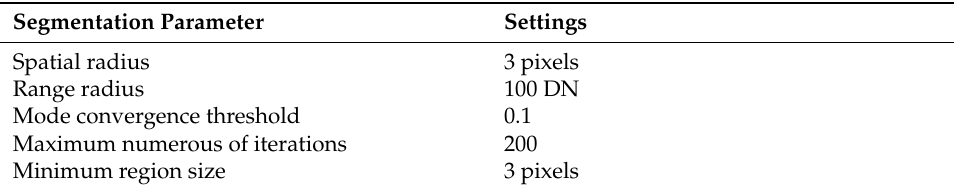
Table 6. Segmentation parameters.